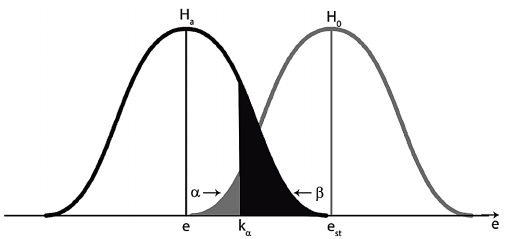
Figure 8. Statistical hypothesis testing. The buoy is moving primar- ily in one direction between two maximum extensions (determined by the anchor chain). The slack-tide positions have been determined using Fig. 4. The uncertainty in the observed extension of the buoy is modelled through a distribution. Shown here is the situation for high-water slack. The moment of slack tide is announced once the observed extension goes beyond the critical value/threshold k α